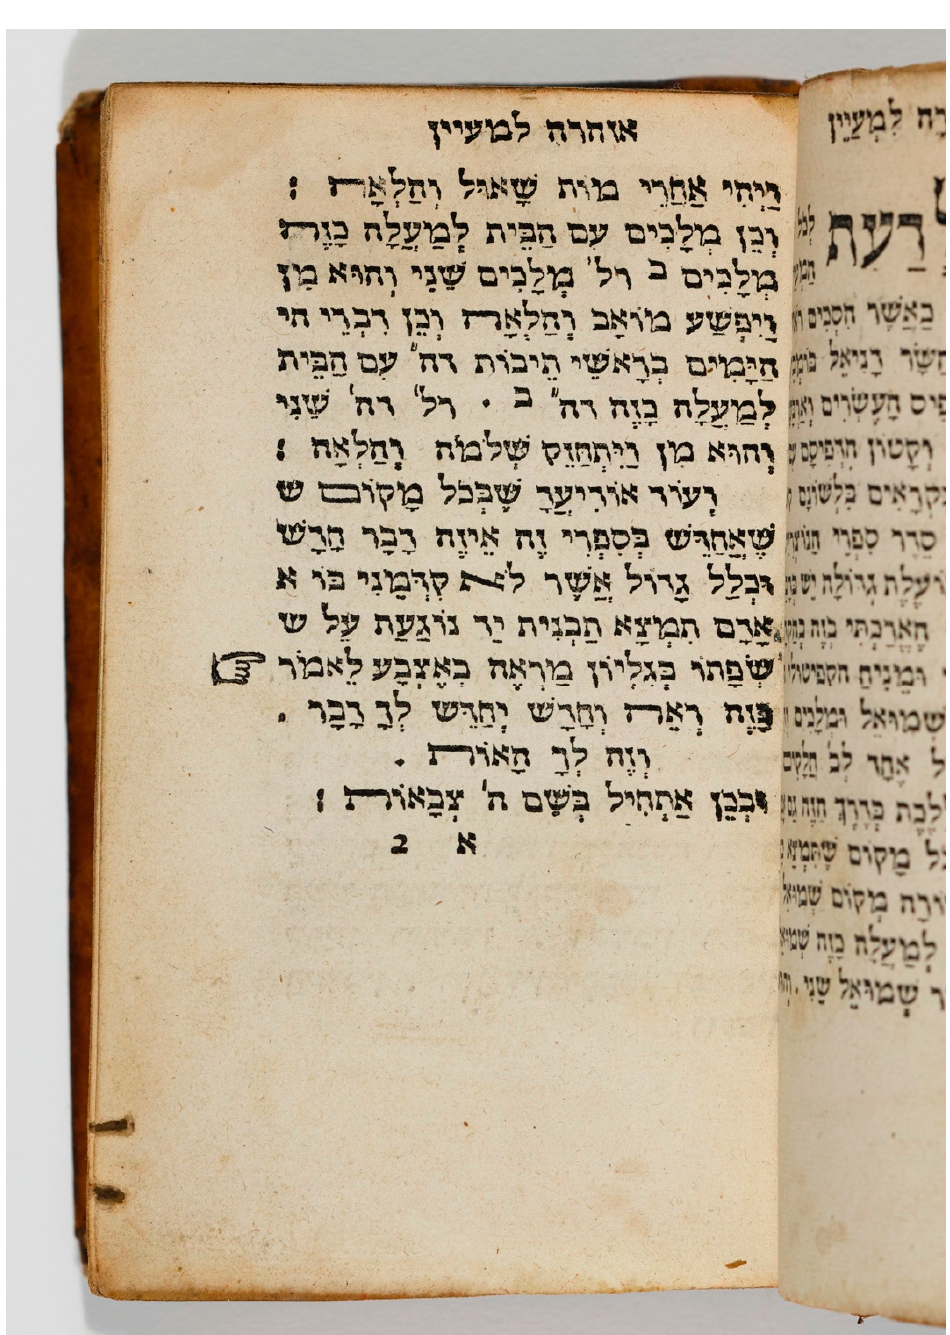
Figure 32. Sefer Masoret ha-Masoret, with Manicule; Marsh’s Library C.3.4.40.